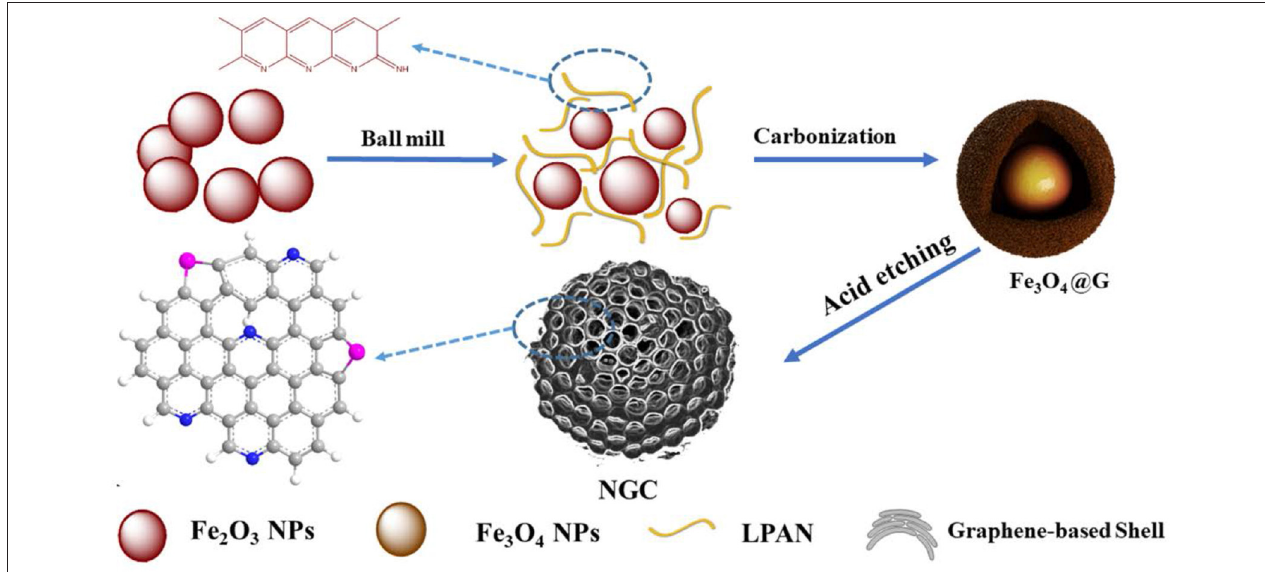
FIGURE 1 | Schematic illustration of the formation route of Fe 3 O 4 @G and NGC.